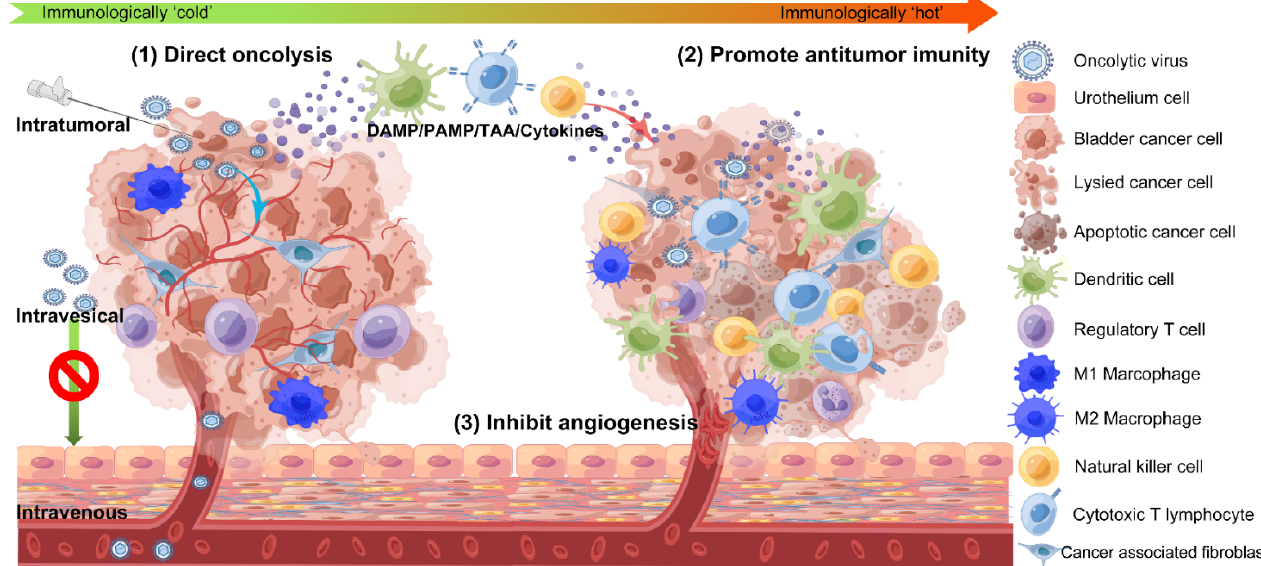
Figure 1. Proposed antitumor mechanisms of oncolytic viruses in bladder cancer. The oncolytic viruses (OVs) can be administered intravenously, intravesically, and intratumorally. OVs selectively infect bladder cancer cells while avoiding harming healthy cells. After the infection, OVs replicate in bladder cancer cells and finally lyse the malignant cells. The infection and direct oncolysis result in the release of cell-derived damage-associated molecular patterns (DAMPs), viral pathogen-associated molecular patterns (PAMPs), soluble tumor-associated antigens (TAAs), and various cytokines. These molecules recruit and activate antigen-presenting cells such as dendritic cells (DCs), natural killer (NK) cells, and other immune cells to the infection site. DCs take up soluble tumor antigens and then activate adaptive T cell responses against the tumor at regional lymph nodes. NK cells and cytotoxic T lymphocytes can recognize and kill tumor cells. Finally, OVs break down the immune suppressive tumor microenvironment that consists of immunosuppressive cells and a dense stroma to establish an immunologically “hot” tumor microenvironment. This remodeling promotes the immune system to recognize and kill primary, metastatic, or recurrent malignant cells. In addition, many OVs can effectively suppress intratumor angiogenesis and reduce the supply of nutrients and oxygen to the tumor by direct lysing the vascular endothelial cells, instigating the formation of microthrombosis, and expressing anti-angiogenesis viral proteins.